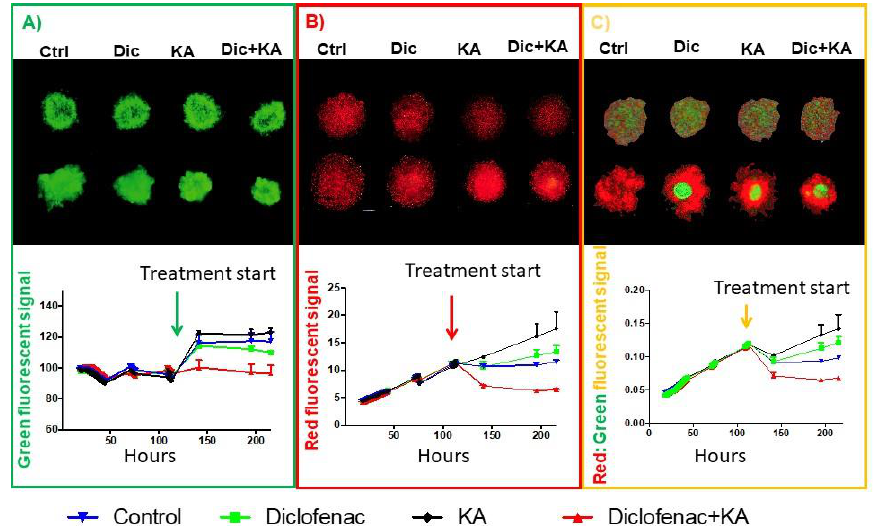
Figure 4. Spheroid 3D co-culture shows the role of evolutionary designed treatment in tumor cells population dynamics. ( A ) Images of the spheroids of MCF7 cells that were fluorescently tagged with GFP in monoculture. ( B ) Images of spheroids of MDA-MB-231 cells fluorescently tagged with RFP in monoculture. ( C ) Co-culture of MCF7-GFP and MDA-MB-231-RFP. The ratio in co-culture is 1:1 for experiment initiation. The top row are the pretreatment images and the bottom raw for each condition is the last time point images. Underneath the images is a fluorescent signal analysis of the spheroid experiment under all four treatment conditions. Each experiment has 8 replicates. The data are represented as mean with the error bars as SD.